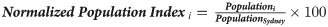
Relative socio-economic disadvantage index vs. normalized population-based index values of the UCLs (where Normalized Population Index i= PopulationiPopulationSydney×100).